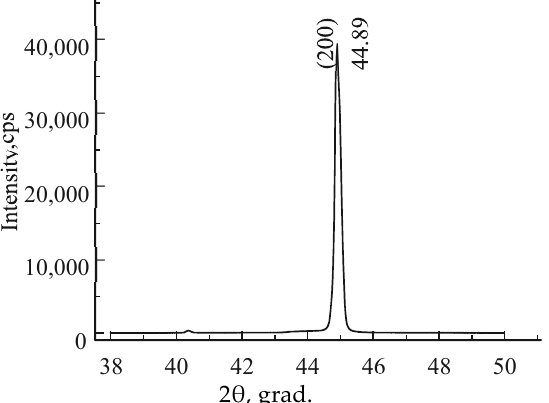
2 θ , grad. Figure 6. X-ray diffraction pattern of a lithium fluoride single crystal with indication of the X-ray scattering angle 2 θ = 44.89 ◦ and Miller indices (200) above the diffraction peak [34]. It turned out that the dispersion ratio for a single crystal LiF is very different from the dispersion of plasmons in fused quartz and is a very narrow loop that can practically be approximated by a straight line. Such a dispersion curve for a lithium fluoride single crystal is shown in Figure 7.